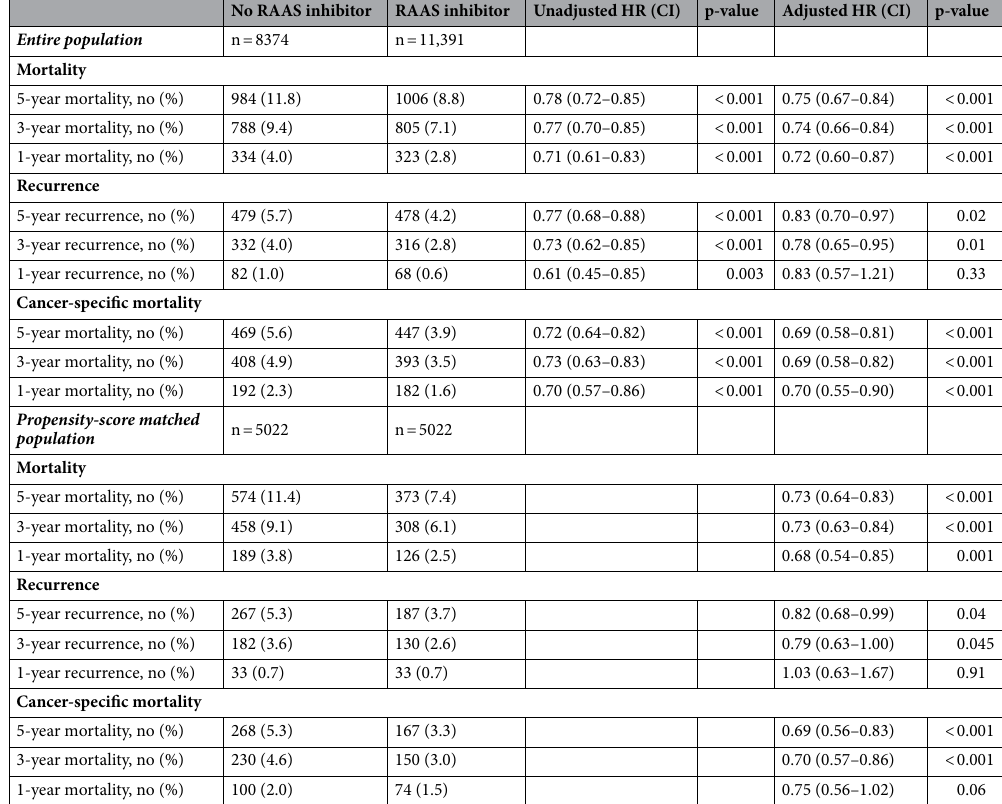
Table 2. Mortalities according to RAAS inhibitor use. Multivariable adjustment included age, sex, diabetes, coronary artery disease, heart failure, stroke, deep vein thrombosis, chronic kidney disease, chronic lung disease, anemia, preoperative chemotherapy, preoperative radiotherapy, preoperative metastasis, the number of intraoperatively transfused red bold cell units, continuous infusion of inotropes, duration of operation and preoperative use of RAAS inhibitors. RAAS renin–angiotensin–aldosterone system, HR hazard ratio, CI confidence